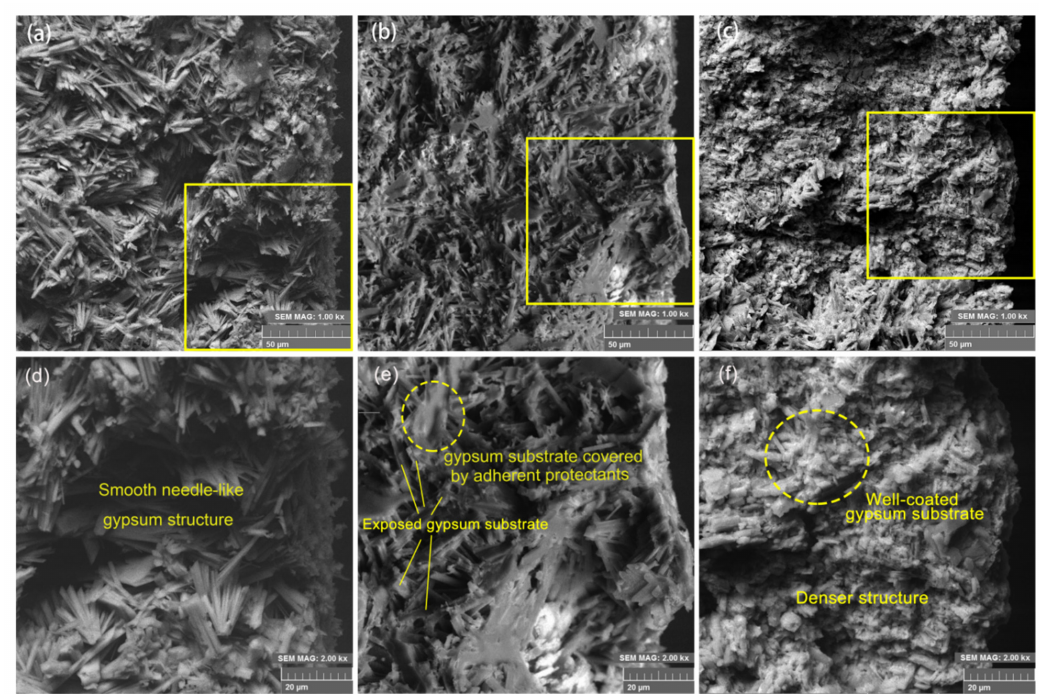
Figure 7. Cross-section morphology of the specimens with different magnifications (the yellow rectangle areas of the ( a – c ) are magnified to ( d – f ), respectively), ( a , d ): blank specimen, ( b , e ): treated specimen before water supply, ( c , f ): treated specimen after water supply.